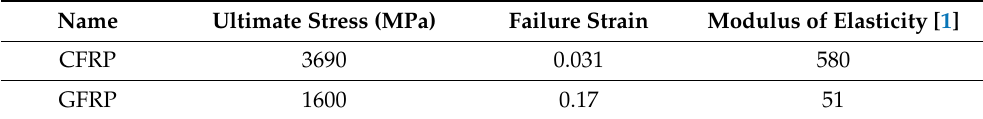
Table 3. Mechanical Properties of FRP